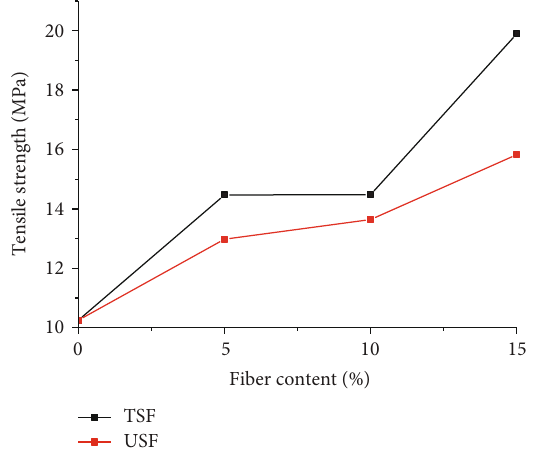
Figure 7: Tensile strength of composites from treated and untreated sisal fi ber.